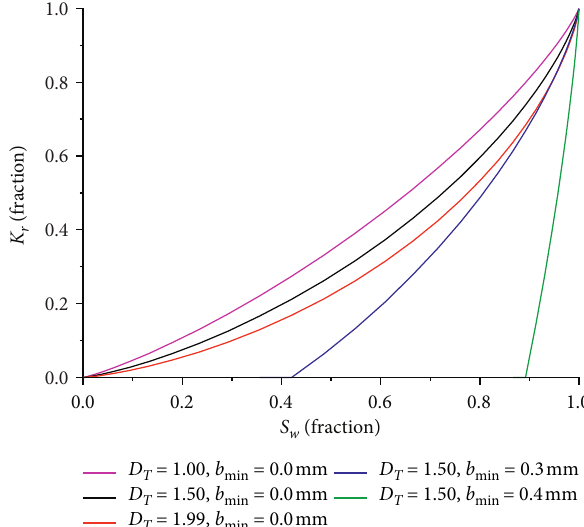
Figure 4: Predicted relationships between relative permeability and saturation with different tortuosity fractal dimensions and minimum apertures. The parameters used in equations (32) and (33) are u � 0.3mm and δ �